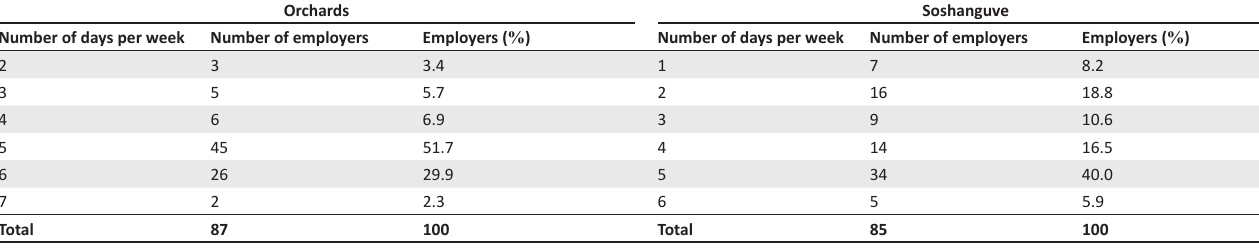
TABLE 4: Number of days per week employed in Orchards and Soshanguve in 2007. Orchards Number of days per week